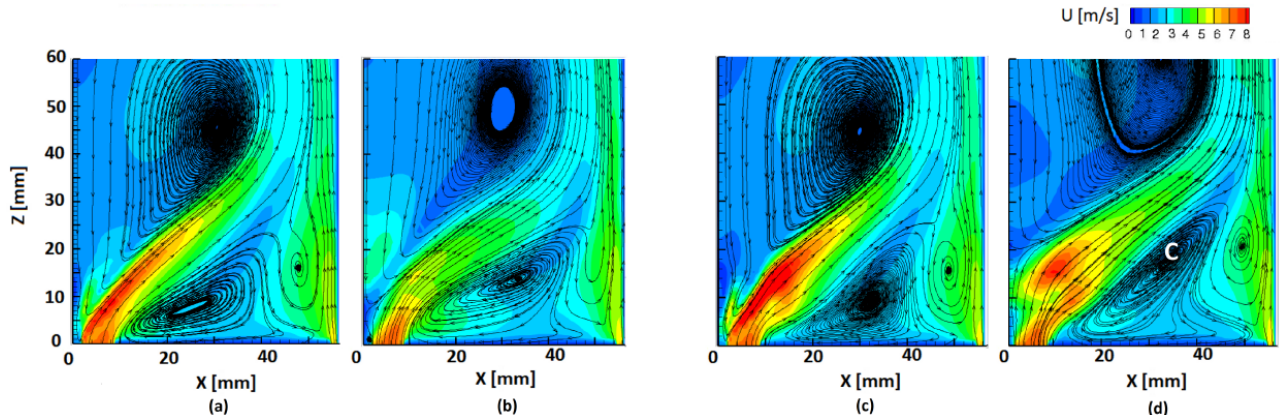
Figure 16. Velocity magnitude profile for combustion model ED with ( a ) RNG k- (cid:101) , ( b ) k- ω and FGM with ( c ) RNG k- (cid:101) and ( d ) k- ω